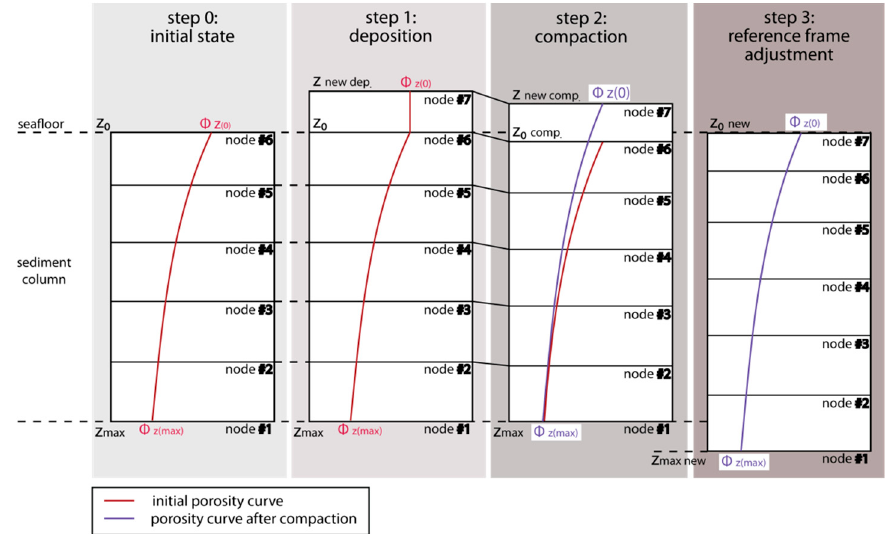
Figure 2. Schematic illustration of the reference frame concept used in the model previously validated by Schmidt et al. [60]. Starting from the left: Step 0 represents the initial state of modeled sedimentary column extending from the seafloor (z 0 ) to the maximum sediment depth (z max ) with an initial porosity curve (red line) ranging from high seafloor porosity value ( ɸ z(0) ) up to low maximum sediment depth value ( ɸ z(max) ) containing an initial number of nodes in the z-direction. In step 1, a new sedimentary layer, represented by the node #7, has been deposited on top of the existing column. The top of the new layer has been marked by the z new dep. symbol and porosity of the new layer remains constant with depth. Step 2 depicts a compaction process of all deposited layers according to their lithological properties (in the drawing assumed to be homogeneous for simplicity) and a new porosity curve (violet line) as a result of this process. Finally, step 3 shows a vertical adjustment of the reference frame to match the upper boundary of sedimentary column with the seafloor coordinates z 0 and a new porosity curve (violet line). Note that porosity curves, including initial (seafloor) porosity values, are only symbolic and do not represent the real compaction properties of the Blake Ridge sediments.